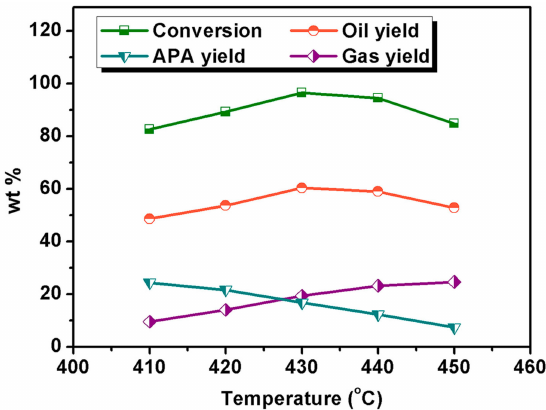
Figure 3. Results of the catalytic hydrogenation of Dahuangshan coal with Fe 3 O 4 nanoparticles at different temperatures.